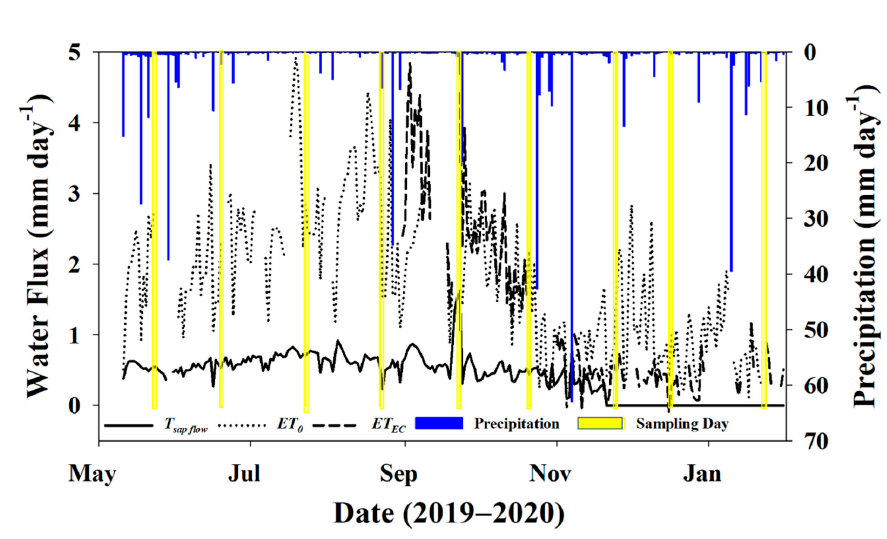
Figure 5. Daily transpiration ( T sap flow ), reference evapotranspiration ( ET 0 ), actual evapotranspiration ( ET EC ), and precipitation for the study period. Days where there was an isotope sampling event (soil and twigs) have been highlighted in yellow.